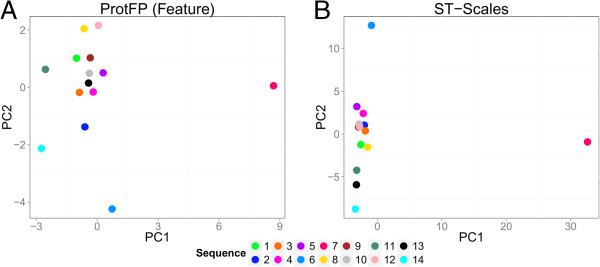
PCA plots of the best and worst performing descriptor sets on the NNRTI benchmark. (A) The simplified representation of ProtFP (Feature) proves to be an advantage on this congeneric data set as the distance in PCA space better correlates to the distance in bioactivity space. (B) The ST-Scales on the other hand perform the least well, and it can be hypothesized that the tight clustering in one part of the plot does not correlate to bioactivity space.